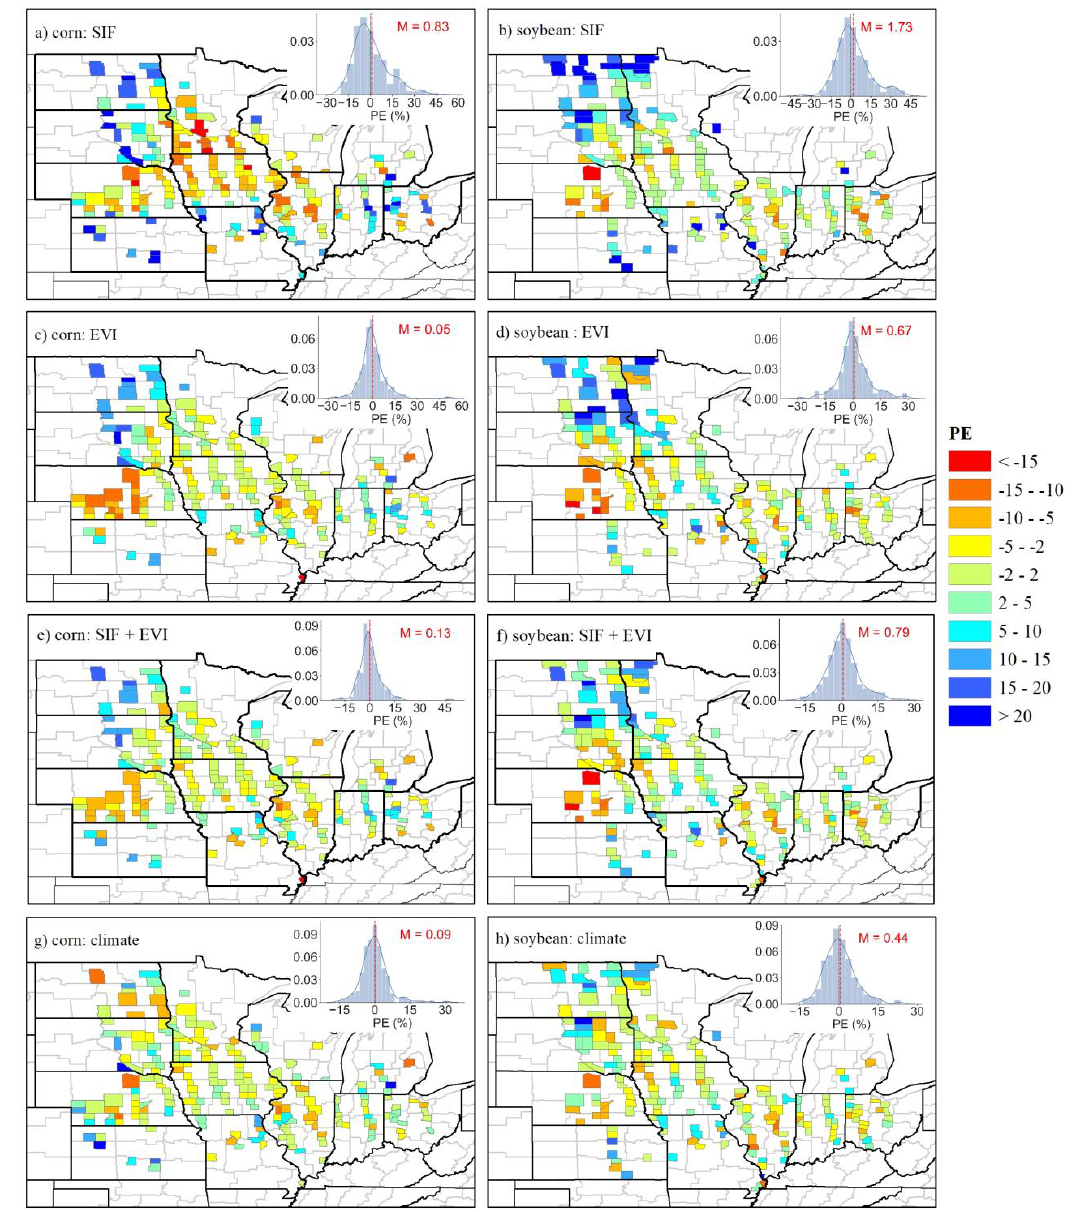
Figure 6. Spatial distribution of percentage error (PE) of county-level corn and soybean yields estimated by models using either satellite or climate predictors. Left panels are the maps for the corn, and right are for the soybean. The figure includes results from models that only input SIF (a and b), only input EVI (c and d), input both SIF and EVI (e and f), and only input climate data (g and h). In each plot, the density plot in the upright corner presents the overall distribution of PE of all the available counties. The red dashed lines and ‘M’ in the density plots represent the mean values of PE, and the black ones are the referenced lines located at zero. Positive values mean that estimated yields were lower than census data, vice versa.